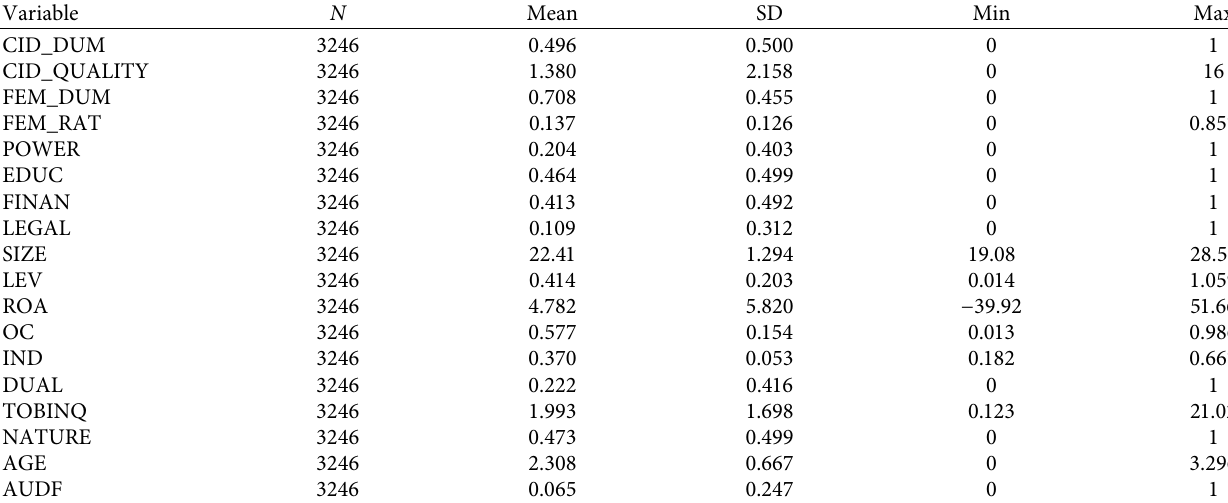
Table 6: Descriptive statistics of